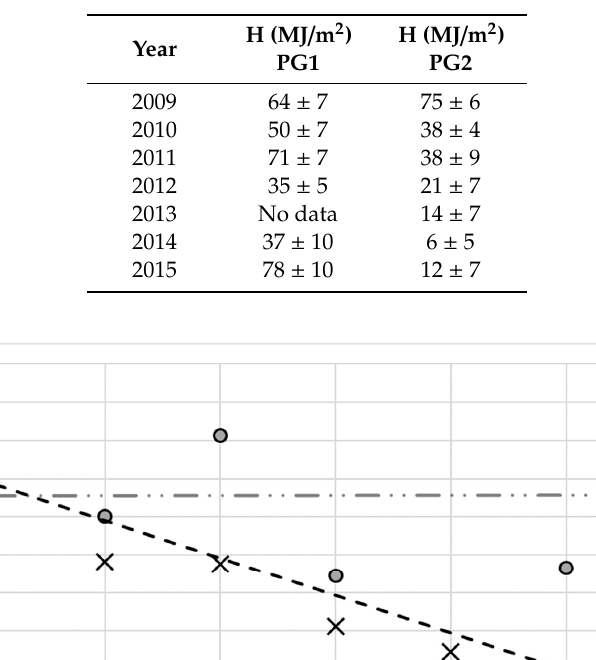
Table 6. Annual integration of soil surface energy exchange (H) for PG1 and PG2 boreholes.